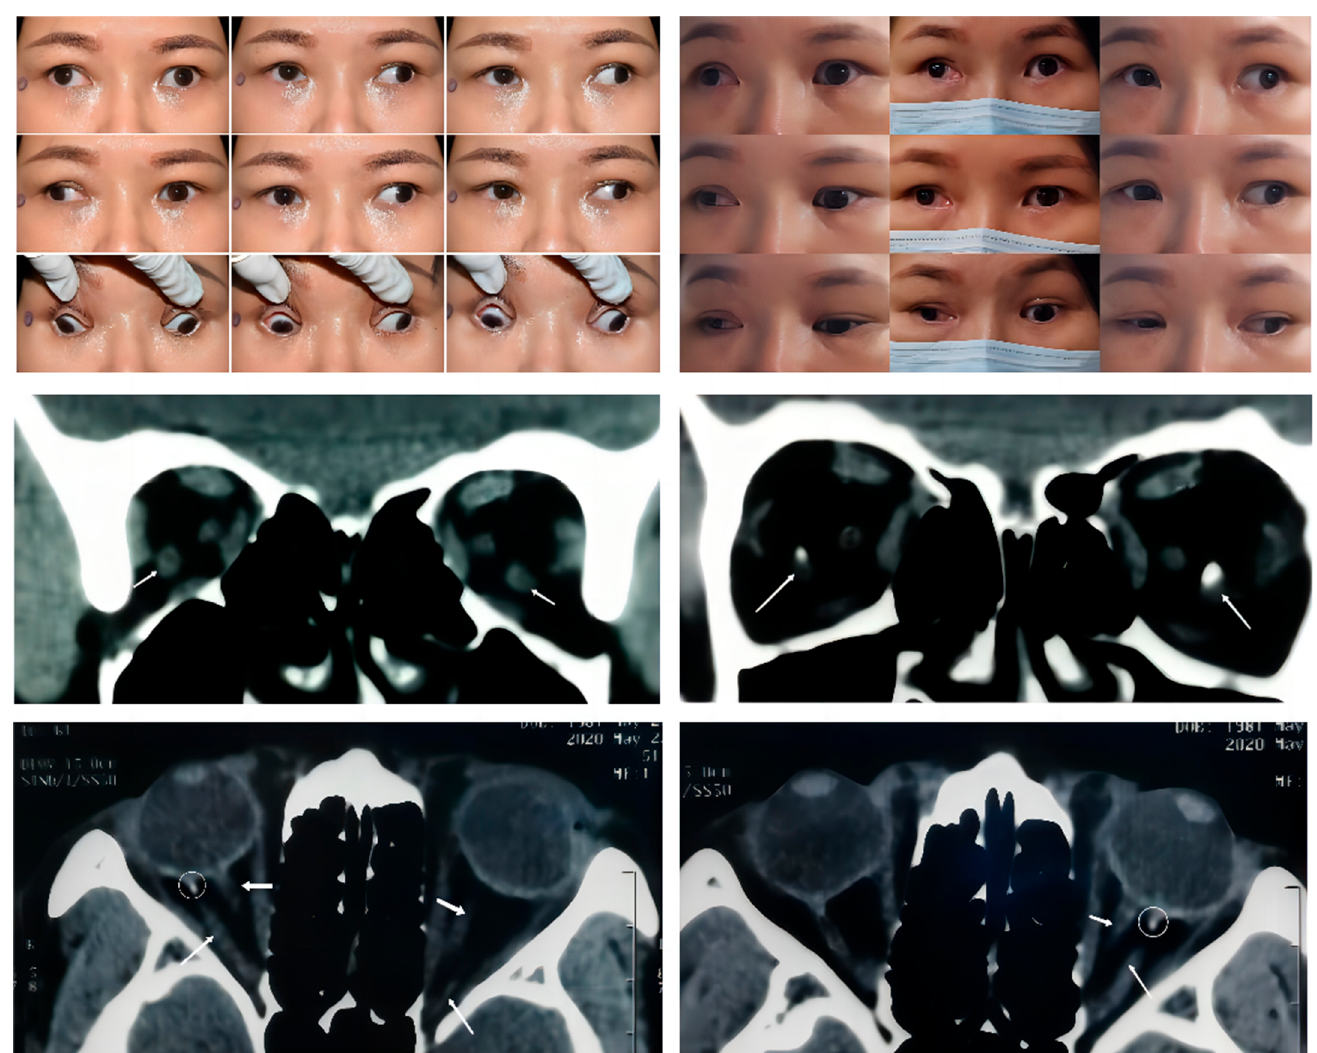
Figure 1. Upper panel : Nine gaze photographs of Case 1 showing a preoperative 65 PD alternating exotropia and a large A pattern strabismus. A moderate bilateral limitation of adduction and supraduction and mild bilateral limitation of infraduction were present in this case (left). Sixteen months after a second strabismus surgery (right), there was a slight improvement in the adduction of the right eye. A residual 25 PD exotropia and large A pattern strabismus remained. Middle Panel : Arrow in the coronal CT scan indicates a bilateral symmetric accessory extraocular muscle. The high-density image within the muscle suggests a local calcification just behind the posterior pole of the eyeball (the right picture). Bottom Panel : Thin arrow in the axial CT scan indicates that the accessory extraocular muscle in both eyes originat from the apex of the orbit and inserting into the posterior globe lies between the lateral rectus and optic nerve. Thick arrow: the optic nerve. Circle: local calcification within the muscle.